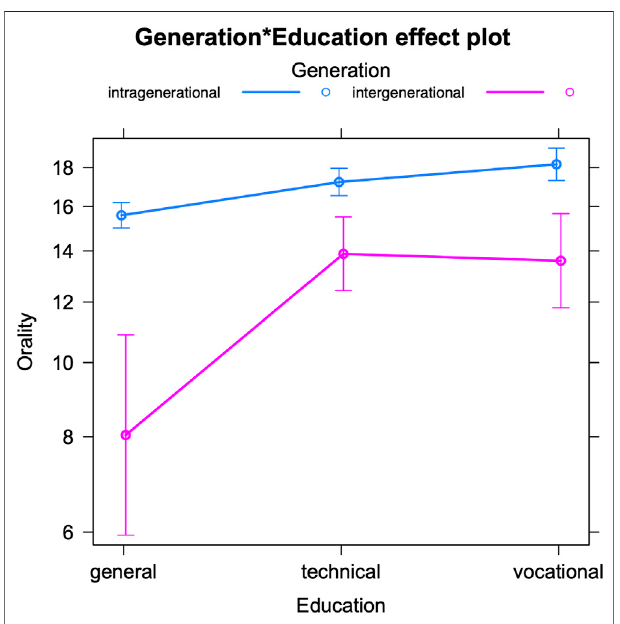
FIGURE 3 | Oral markers in intra-vs. intergenerational talks, by the author ’ s education (predicted counts per 100 tokens).